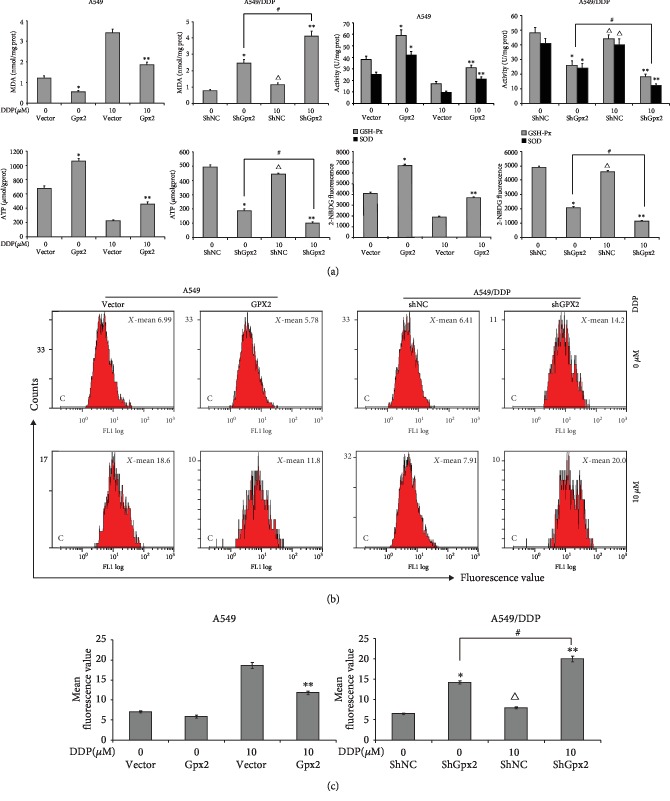
Oxidative stress and metabolite analysis. (a) Cellular malondialdehyde (MDA) production, activity of glutathione peroxidase (GSH-Px) and superoxide dismutase (SOD), adenosine three phosphate (ATP) production, and glucose uptake were analyzed in A549 cells and A549/DDP cells with or without DDP treatment. (b, c) Reactive oxygen species (ROS) testing by flow cytometry in A549 cells and A549/DDP cells with or without DDP treatment. ∗p < 0.05 vs. control (without DDP), ∗∗p < 0.05 vs. control (with DDP), △p > 0.05 vs. ShNC (without DDP), and #p < 0.05.